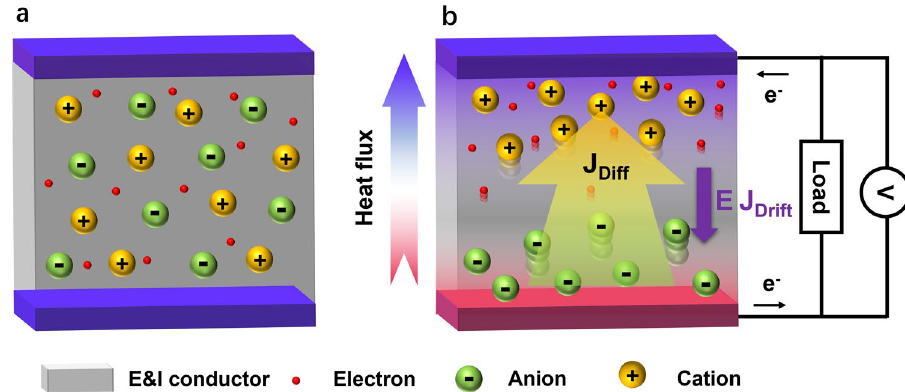
Fig. 1 a Schematic diagram of the ion–electron conductor without an applied temperature gradient, the ions and electrons are evenly distrib- uted, and there is no potential difference. The electrons here refer to the carrier in the E&I conductor. b Schematics of the working principle under the condition of ion–electron thermoelectric